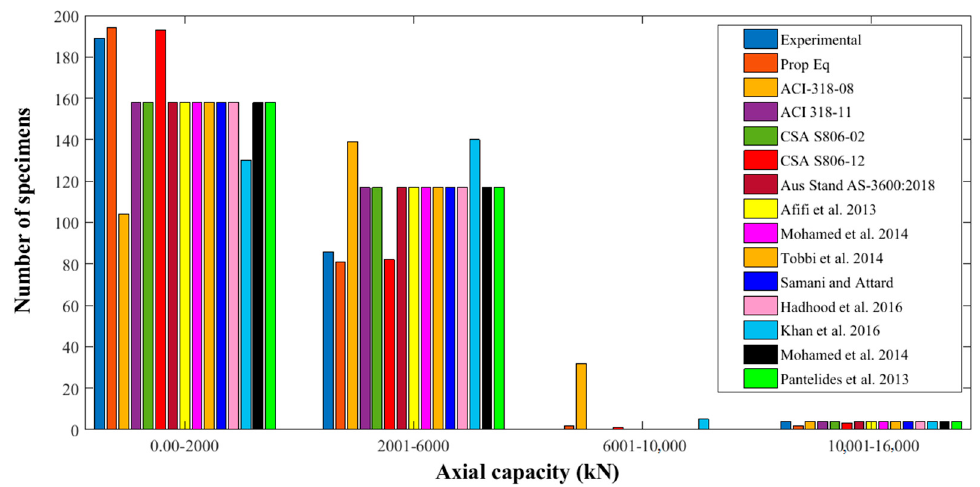
Figure 4. Distribution of AS of fiber-reinforced polymers (FRP)-reinforced columns attained from various models.